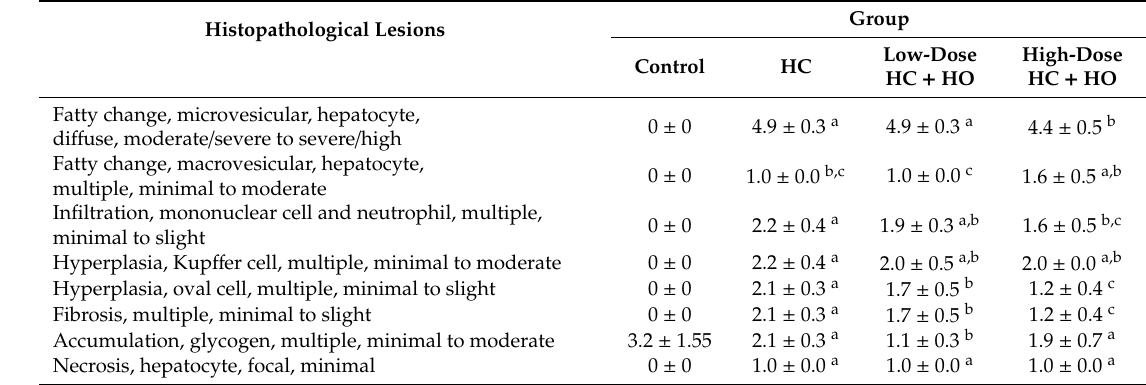
Table 6. Liver pathological score of each group.